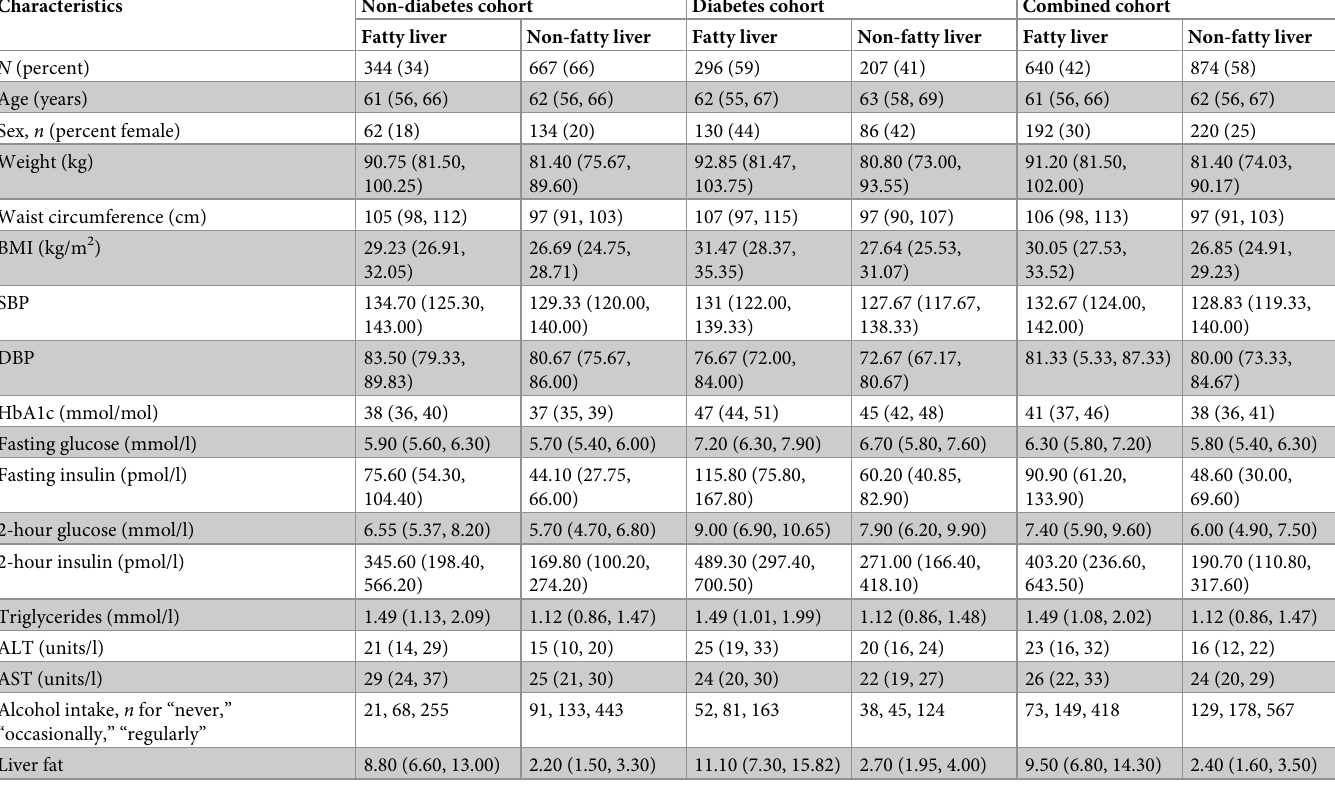
Table 1. Characteristics of IMI DIRECT participants in the non-diabetes, diabetes, and combined cohorts separated for individuals with fatty liver versus non-fatty liver.